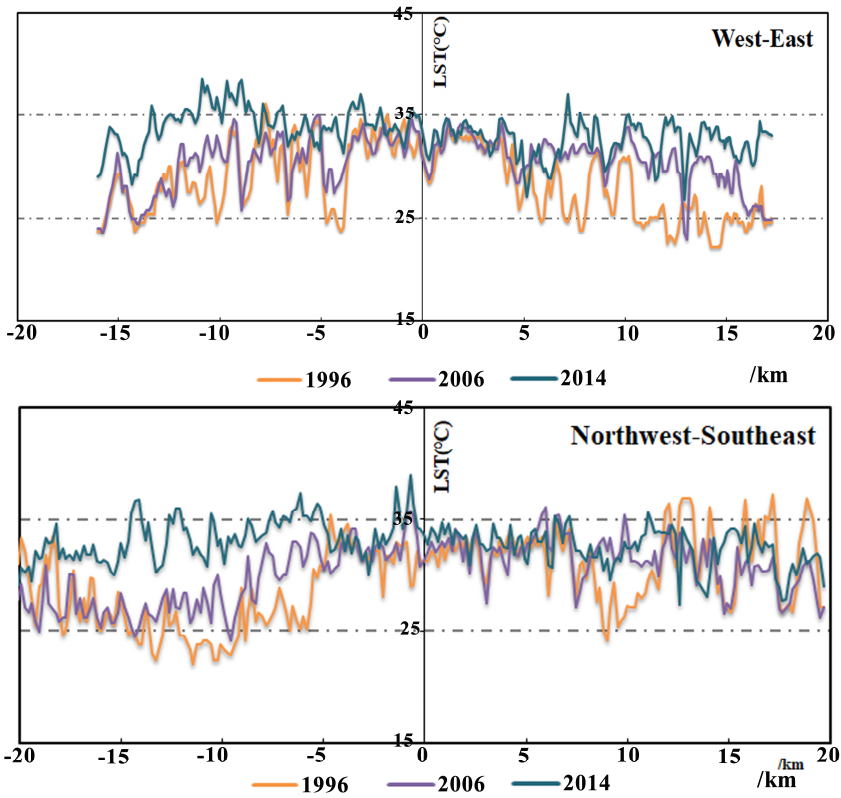
Figure 4. Multitemporal and multidirectional LST profiles of Zhengzhou City.